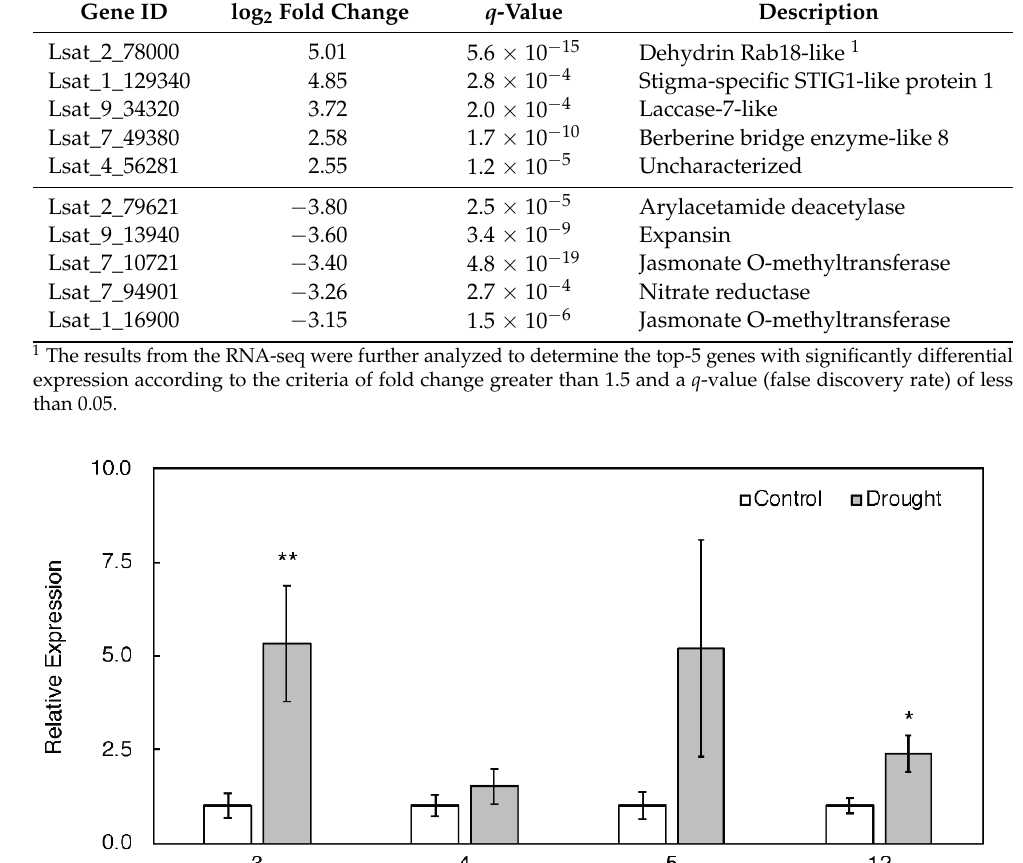
Table 2. Each top-five upregulated and downregulated gene with 7 days’ drought stress in lettuce identified via the RNA-seq analysis.